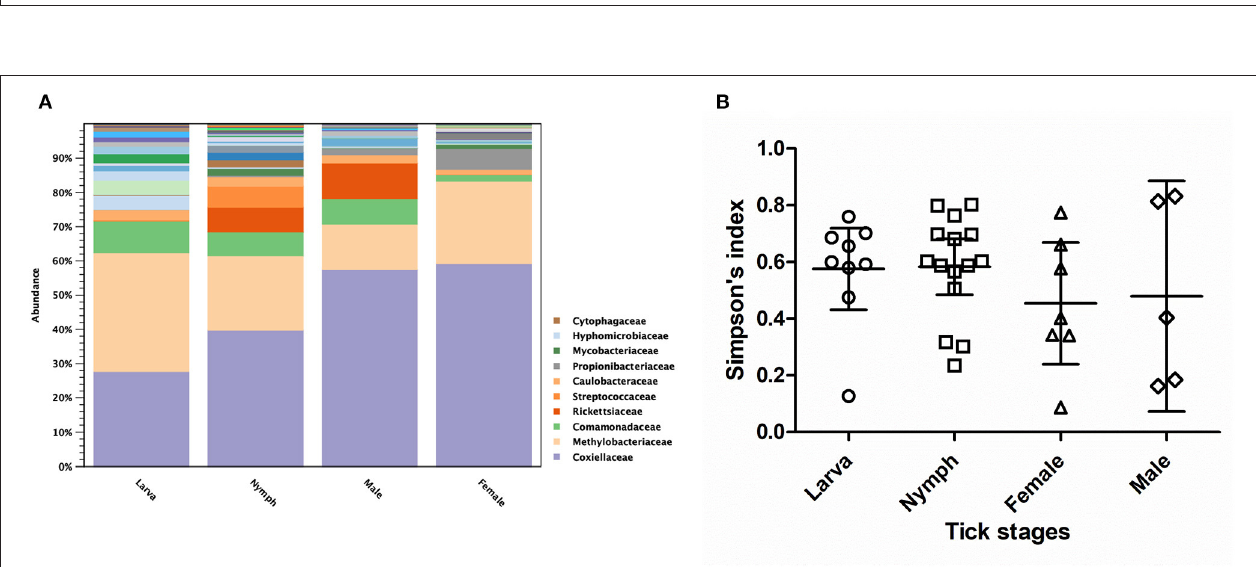
FIGURE 4 | Alpha diversity measures (Simpson’s index) based on 16S rRNA gene database for each tick genus (A) and Francisella persica infection status (B) . The statistically significant differences between groups are indicated (* p -value < 0.05, ** p -value < 0.001). The solid lines show mean and 95% confidence interval (CI) of alpha diversity for each group. Scatter plots and Mann–Whitney U test were created and tested using GraphPad Prism version 5.04.